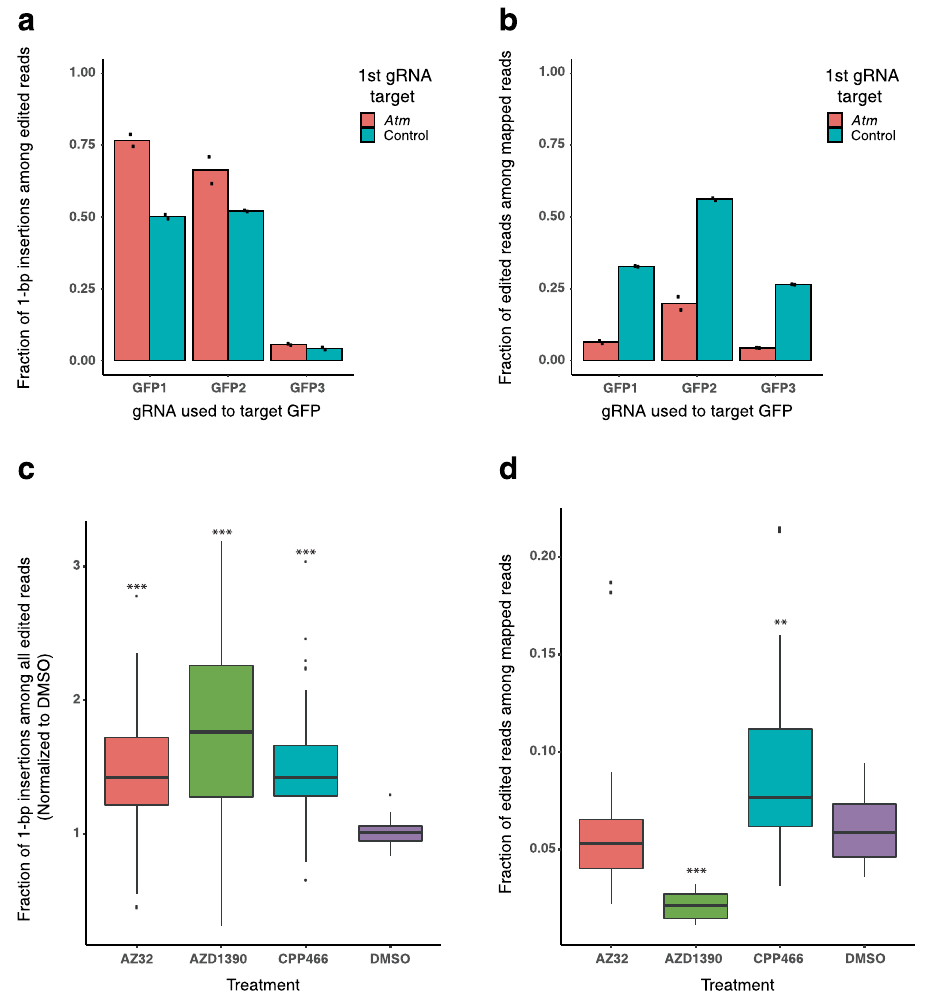
Fig. 3 ATM loss-of-function through genetic knockout or small molecule inhibition leads to increased 1-bp insertion frequency. a Bar chart showing the fraction of 1bp-insertion mutations among edited reads at three GFP-targeting gRNA sites in Atm or control knockout mESCs ( N = 2 biologically independent samples). b Bar chart exhibiting the edited fraction of all mapped reads for each of the conditions described in a , respectively. c Boxplot exhibiting the fraction of 1-bp insertions observed in mESCs for each site of the 48-site library in the presence of known ATM inhibitors or DMSO ( N = 3 biologically independent samples). d Boxplot exhibiting the editing frequency observed for each site depicted in c , respectively. P values were calculated using a one-way ANOVA with Tukey HSD).** p < 0.01, and *** p < 0.001. Boxplot statistics for 1-bp insertion fraction with AZ32: minima = 0.401, lower whisker bound = 0.447, lower box bound = 1.210, center = 1.423, upper box bound = 1.722, and upper whisker bound = 2.350. Boxplot statistics for 1-bp insertion fraction with AZD1390: minima = 0.316, lower whisker bound = 0.316, lower box bound = 1.268, center = 1.763, upper box bound = 2.261, upper whisker bound = 3.191, maxima = 3.191. Boxplot statistics for 1-bp insertion fraction with CPP466: minima = 0.743, lower whisker bound = 0.795, lower box bound = 1.286, center = 1.421, upper box bound = 1.662, and upper whisker bound = 2.074. Boxplot statistics for 1-bp insertion fraction with DMSO: minima = 0.837, lower whisker bound = 0.837, lower box bound = 0.947, center = 1.011, upper box bound = 1.060, and upper whisker bound = 1.163. Boxplot statistics for total edited fraction with AZ32: minima = 0.022, lower whisker bound = 0.022, lower box bound = 0.040, center = 0.053, upper box bound = 0.066, and upper whisker bound = 0.090. Boxplot statistics for total edited fraction with AZD1390: minima = 0.011, lower whisker bound = 0.011, lower box bound = 0.015, center = 0.021, upper box bound = 0.027, upper whisker bound = 0.032, and maxima = 0.032. Boxplot statistics for total edited fraction with CPP466: minima = 0.031, lower whisker bound = 0.031, lower box bound = 0.061, center = 0.077, upper box bound = 0.113, and upper whisker bound = 0.160. Boxplot statistics for total edited fraction with DMSO: minima = 0.036, lower whisker bound = 0.036, lower box bound = 0.046, center = 0.059, upper box bound = 0.075, upper whisker bound = 0.094, and maxima = with 12 pathogenic 1-bp deletion alleles causal to diseases, such as treatment of library-containing mESC cells in the presence of KU- cystic fi brosis - a monogenic disease associated with the cystic 60019 resulted in a signi fi cant 1.65 fold increase in the average 1- fi brosis transmembrane conductance regulator (CFTR) gene - and bp-insertion frequency (Supplementary Fig. 7a) at the expense of familial adenomatous polyposis sites, for which 1-bp insertion MH deletions and non-MH deletions. All 11 pathogenic alleles editing with KKH-SaCas9, a smaller Cas9 orthologue shown to be showed increased 1-bp insertion-mediated pathogenic allele repair amenable to in vivo gene editing 27,28 , should preferentially restore with a maximum of 3.08-fold as much 1-bp insertion (Supple- the pathogenic allele to wild-type genotype. For all 11 gRNA:target mentary Fig. 5b). We note that, without the bene fi t of a predictive pairs in which we detected successful editing, KKH-SaCas9 model of features in fl uencing 1-bp insertion frequency for KKH-